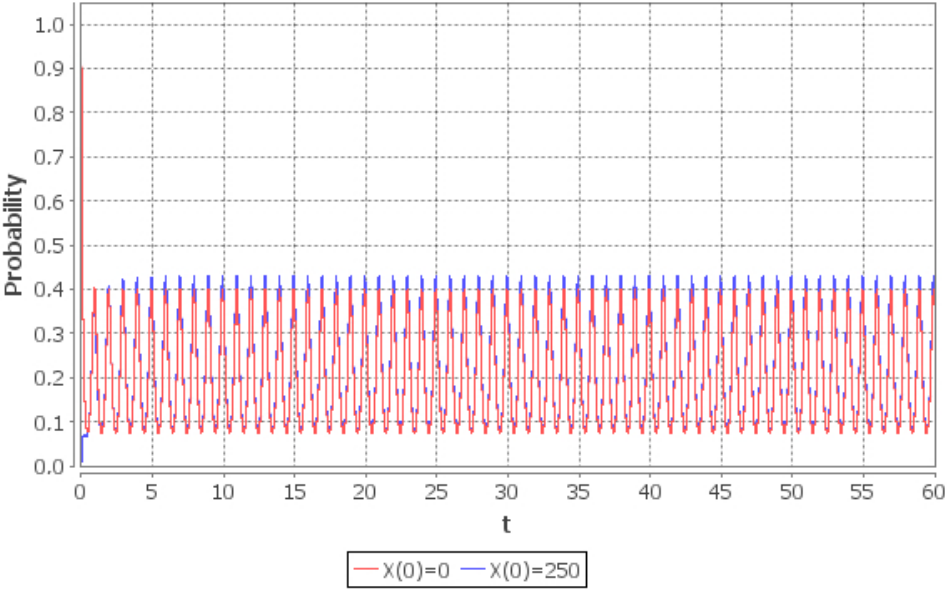
Figure 5. Rate of convergence of the empty system probability p 0 ( t ) in the interval [ 0,60 ] given two